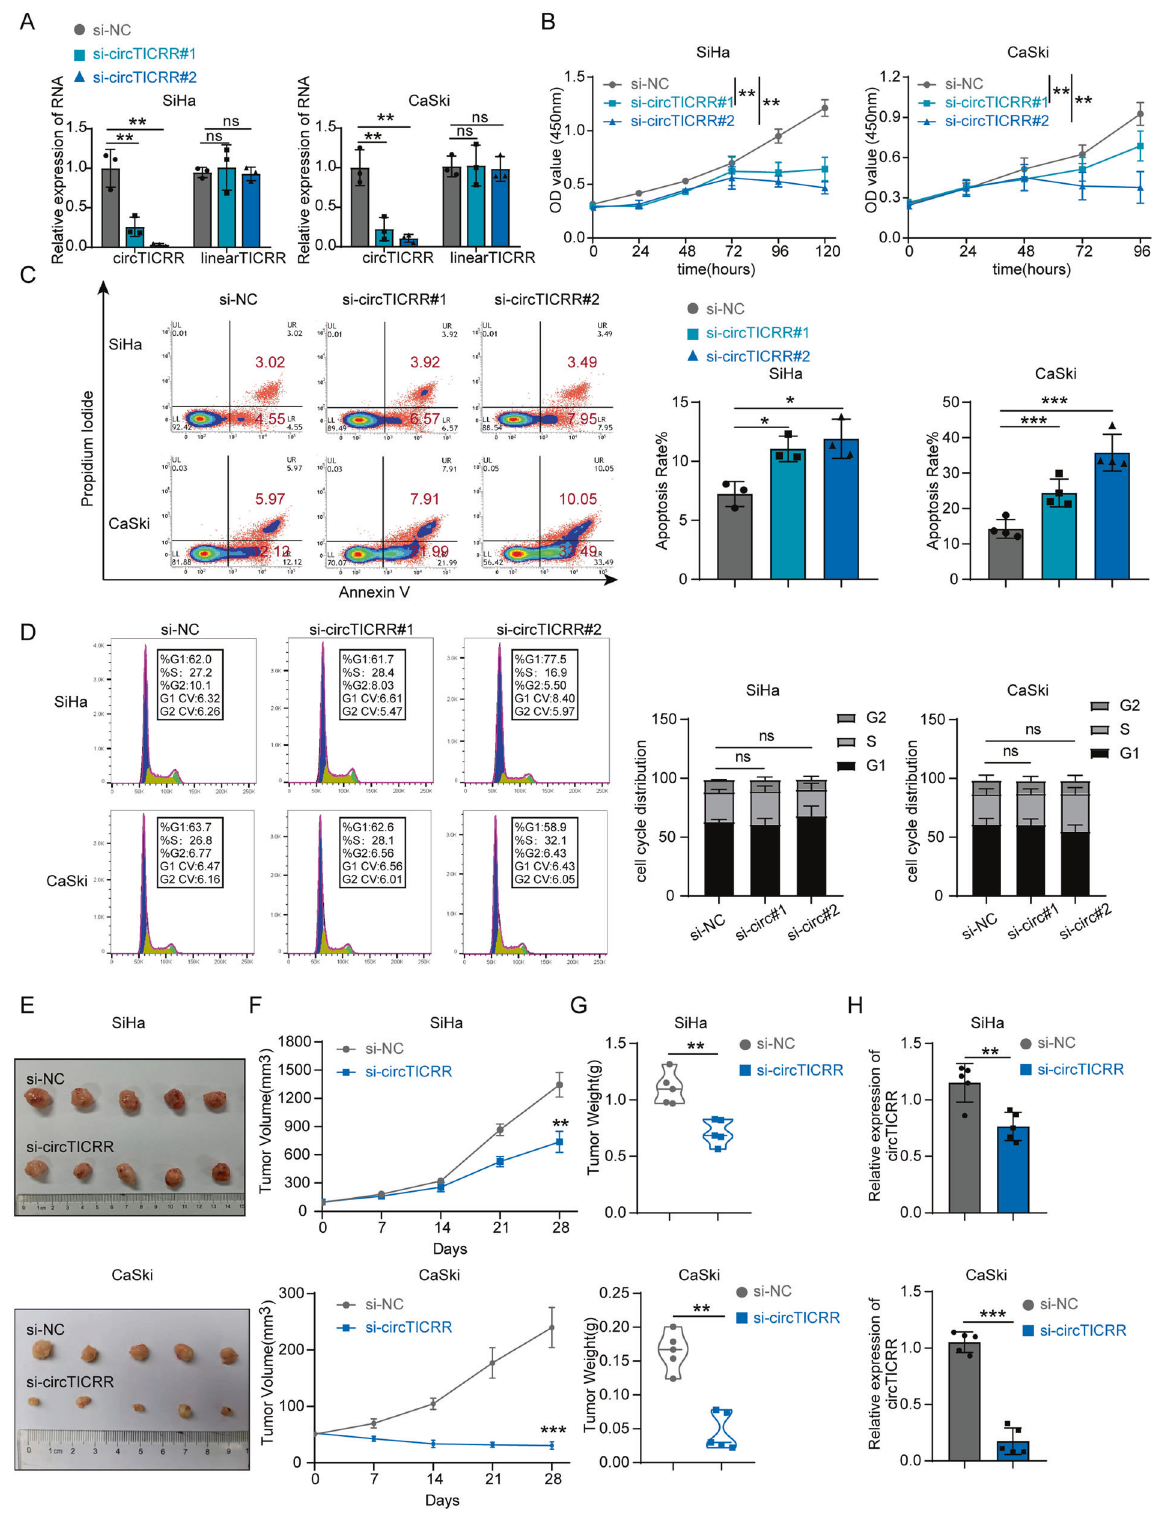
Fig. 2 CircTICRR plays an oncogenic role in cervical cancer in vitro and in vivo. A The relative expression levels of circTICRR or TICRR mRNA were detected by qRT-PCR in the SiHa and CaSki cells transfected with two junction-speci fi c siRNAs targeting circTICRR or corresponding negative control. Cell viability ( B ) was determined by CCK-8 assays, cell apoptosis ( C ), and cell cycle ( D ) was measured by Flow Cytometry in the SiHa and CaSki cells transfected with two circTICRR back splicing-speci fi c siRNAs or a negative control siRNA. Images of tumors E , tumor volume ( F ) and weight ( G ), and the relative levels of circTICRR expression ( H ) in the xenografts treated with si-circTICRR#2 or negative control siRNA after removing the tumors ( n = 5 for each group). Data are representative of at least three independent experiments and p*resented as the mean ± SD. * p < 0.05, ** p < 0.01, *** p < 0.001.